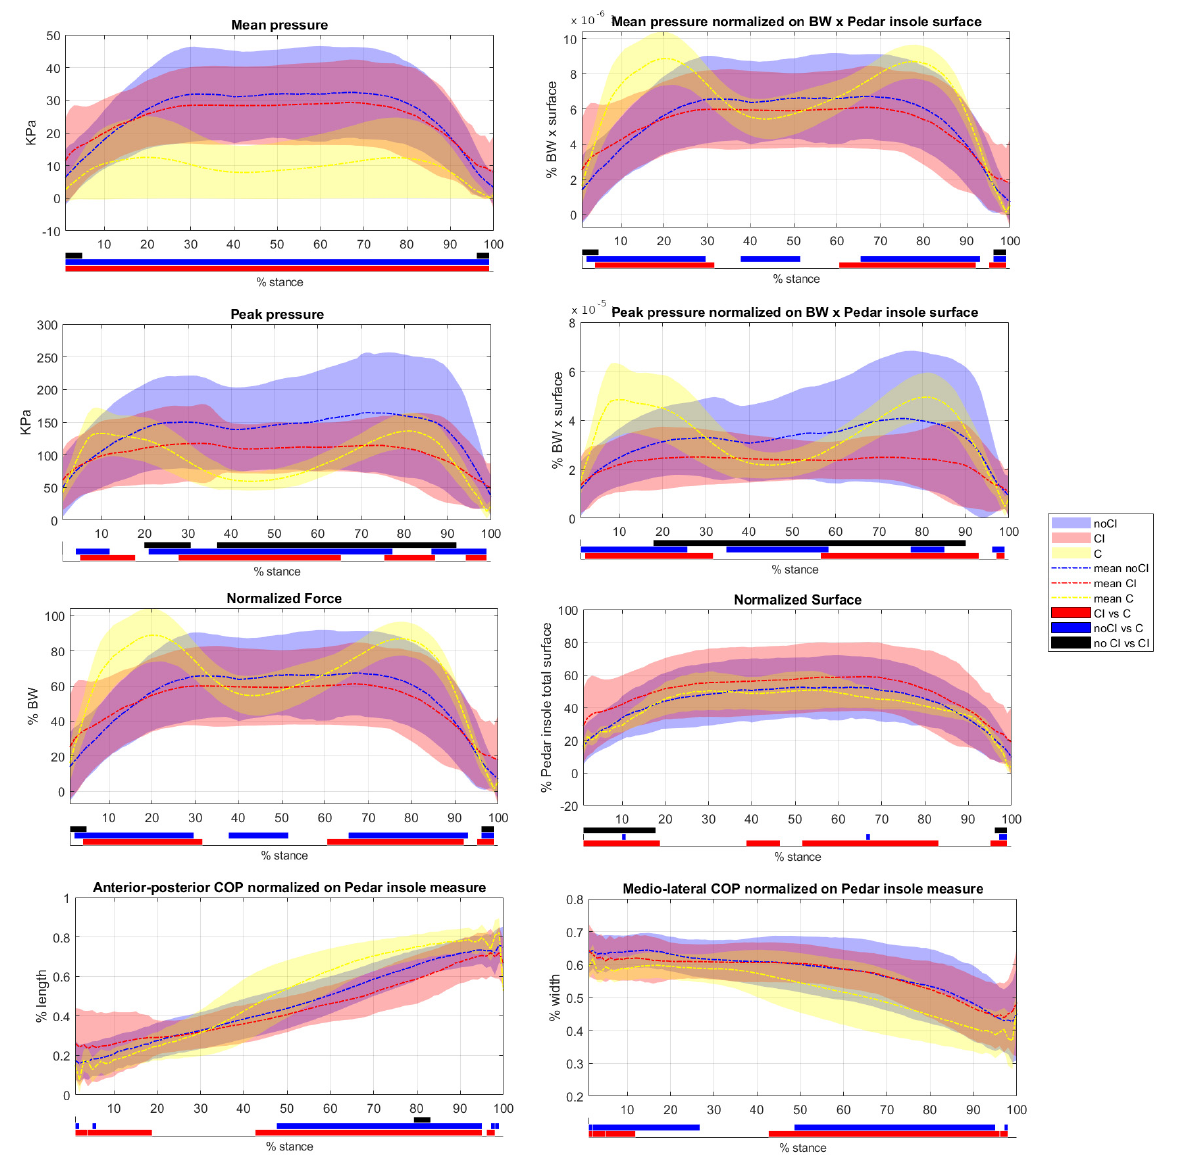
Figure 4. Plantar pressure variables. From top to bottom and from left to right: mean pressure in KPa and mean pressure normalized on body weight (BW) and surface of the plantar pressure insole (%BW*Surface); peak pressure in KPa and normalized peak pressure %BW*Surface; ground reaction force (GRF) normalized on BW (%BW); surface normalized on the total surface of the plantar pressure insole (%Surface); the centre of pressure (COP) displacement normalized on the total surface of the plantar pressure insole in medial-lateral and anterior–posterior directions All results are represented as bands (mean value = dashed line, mean ± 1 standard deviation = shaded area). On the y axis are the units, and on the x axis, the stance phase of the gait cycle percentages. In